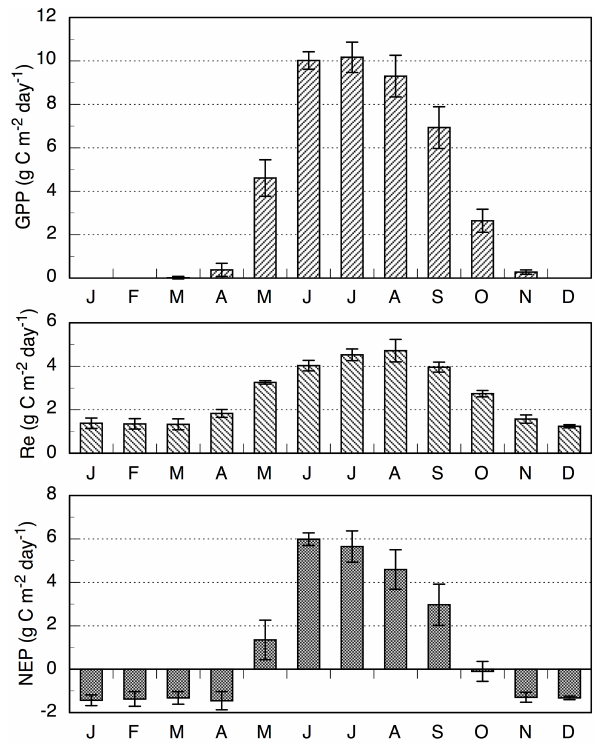
Figure 2. Seasonal variations in gross primary production (GPP), ecosystem respiration (Re), and net ecosystem production (NEP) before the disturbance between 2000 and 2003. The fluxes repre- sent 4-year monthly means and standard deviations of daily values (gCm − 2 day − 1